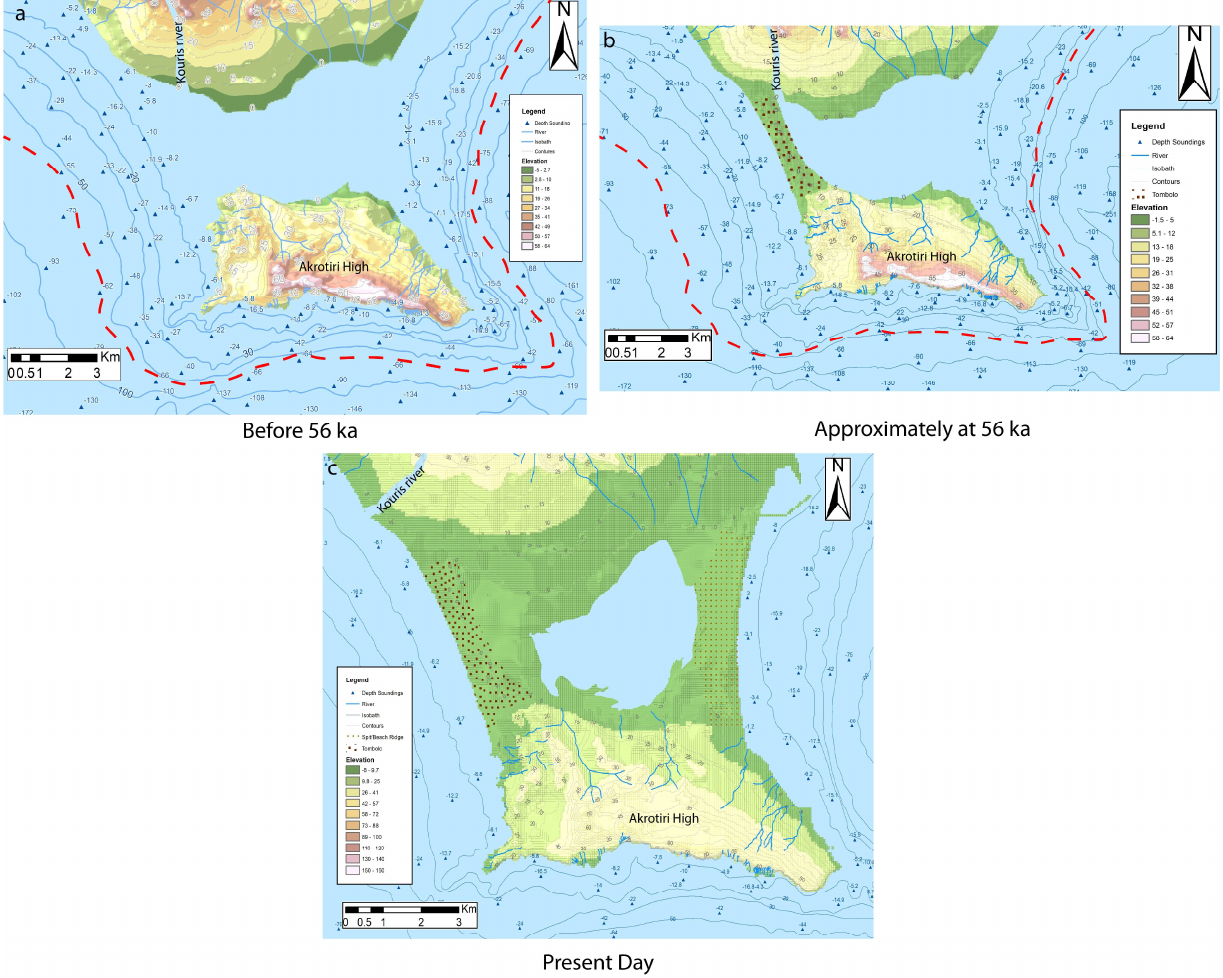
Figure 10. Palaeogeographic evolution of Akrotiri peninsula. ( a ) before 56 ka, red dashed line represent hypothetical palaeocoastline without estimation of G.I.A and tectonics of the area ( b ) at approximately 56 ka, red dashed line represent hypothetical palaeocoastline without estimation of G.I.A and tectonics of the area ( c ) present